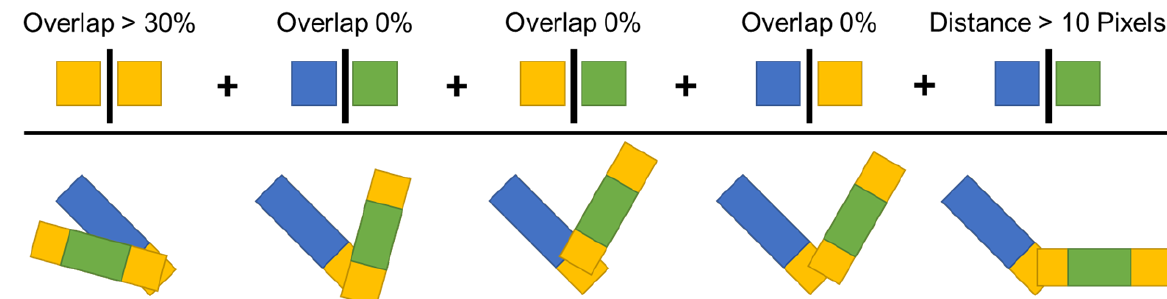
Figure 4. Examples showing how the placement mode evolves as four OCFs and a DCF are chained to achieve a specific criteria. For each example, the blue–yellow rectangle is already in the microstructure, and the yellow–green–yellow rectangle is to be placed. Yellow areas are labelled with meta-local states to correspond to the ends of the rectangle. The final goal is to achieve a placement where rectangles overlap exclusively in the yellow regions, while having a wide angle between them.